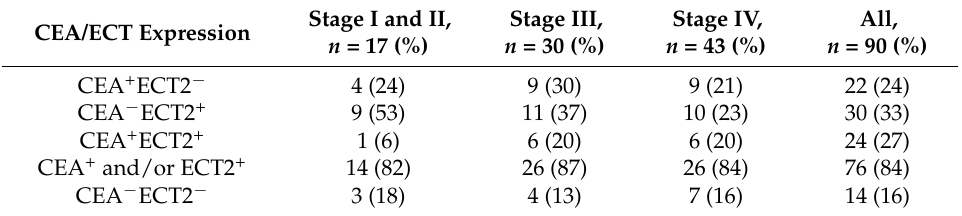
Figure 3. Increasing expression of ECT2 in colorectal cancer patients with serum CEA levels greater than 5 ng/mL and advancing disease. The box plot shows differential expression ratios of ECT2 in patients with detectable serum CEA levels (more than 5 ng/mL). The p- value of a Kruskal-Wallis (KW) test was less than 0.05. Table 2. Proportion of elevated ECT2 and CEA detected in serum in different combination of patients with colorectal cancer.